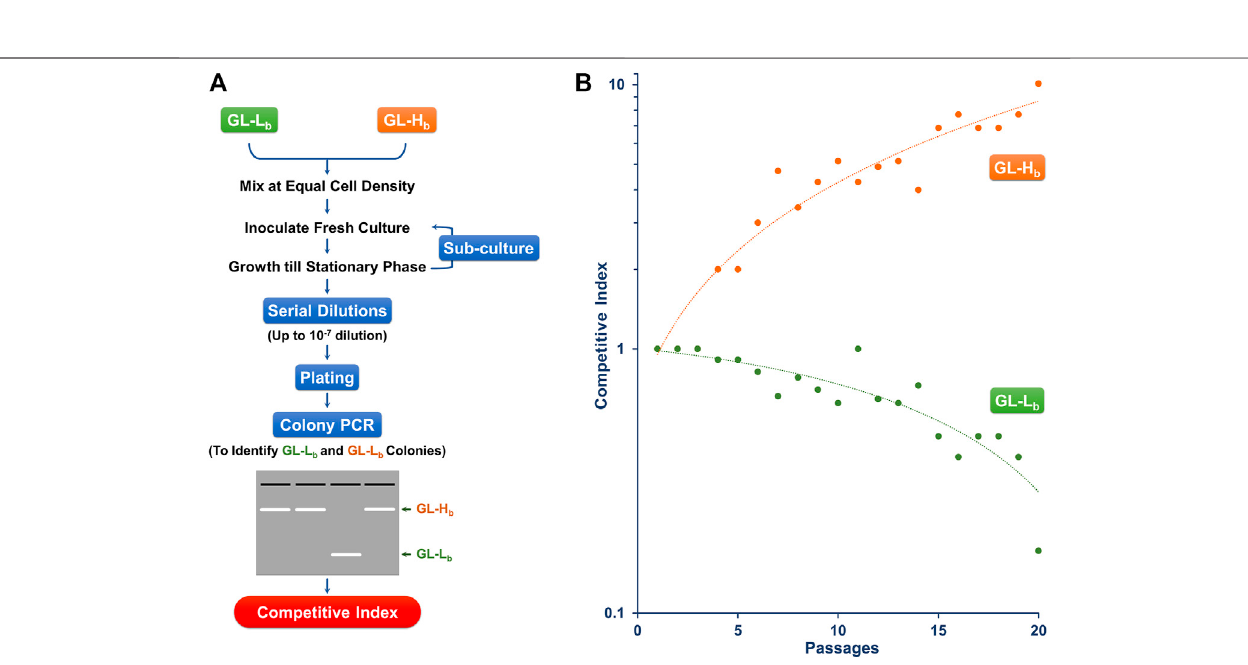
FIGURE3| ChaperoninDepletionleadstoLowerCI (A) StrategyforDeterminingtheCIforGL-L b andGL-H b strains.StationaryphaseculturesofGL-L b andGL-H b strains were mixed at equal cell density, grown to stationary phase and sub-cultured in fresh media for 20 continuous passages. Cells recovered at each passage were seriallydiluted as indicated, spread on LB agar plates and the resulting colonies were scored for their phenotype (GL-L b or GL-H b ),by colony PCR, using vector speci fi c oligonucleotideprimers (B) CI,asadegreeof fi tness,wascalculatedat everypassagefrom aratioofproportionofthecellswithaparticular phenotype andplotted as a function of number of passages. CI trend was similar among the three independent